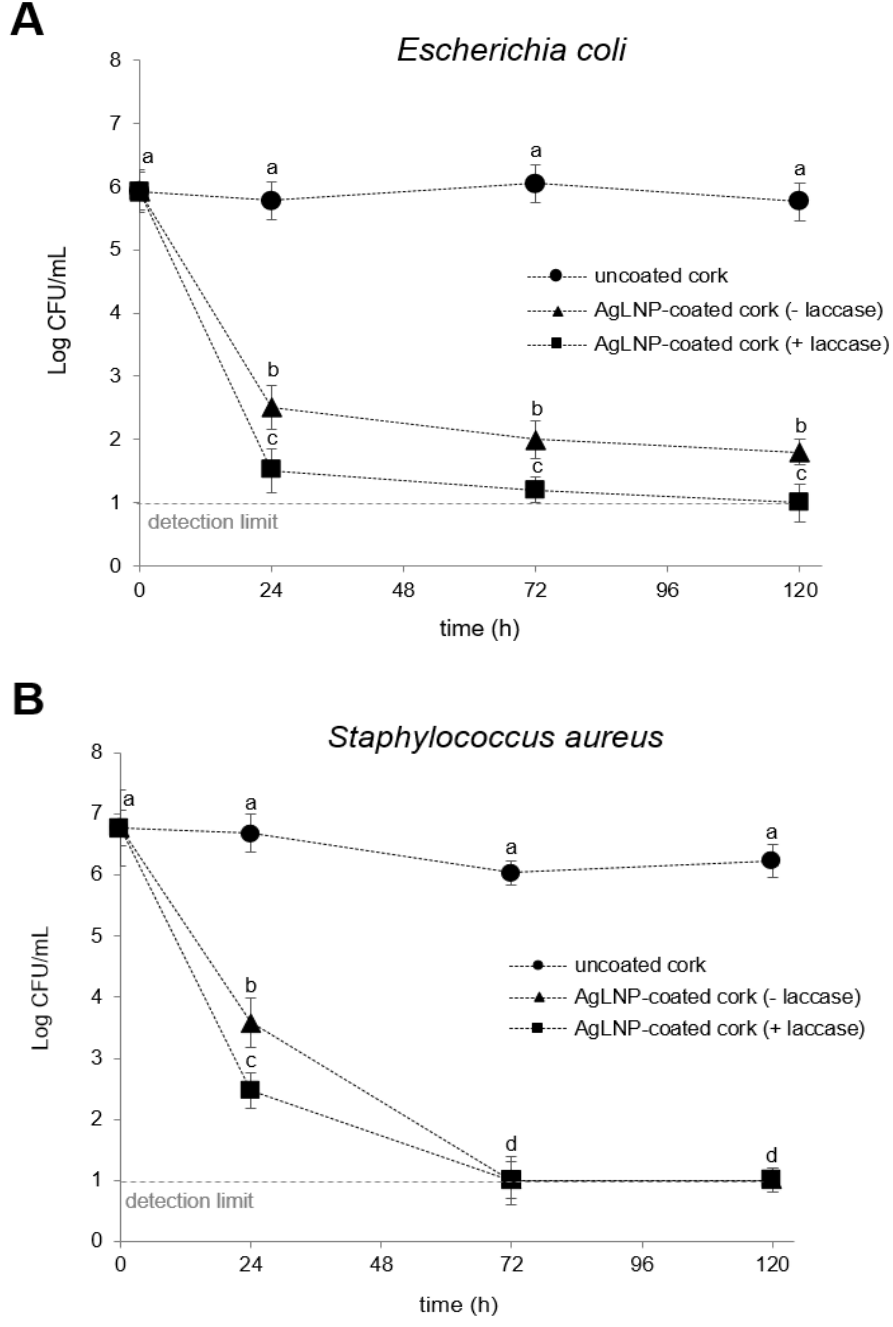
Figure 4. Antibacterial activity in liquid medium of control uncoated cork and AgLNP-coated cork against E. coli ( A ) and S. aureus ( B ). Different letters represent significant differences ( p < 0.05) between groups and at increasing exposure time. Data are reported as the mean value ± standard error (S.E.) from three replicates ( n = 3).